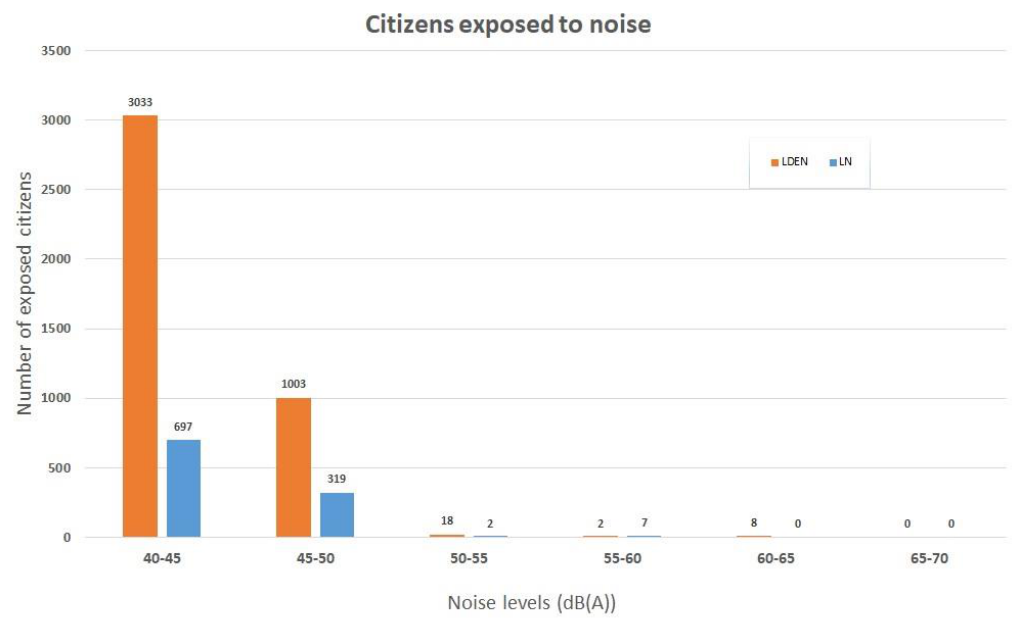
Figure 12. Number of citizens exposed to noise levels above 40 dB(A) L DEN or L N in Scenario 5.